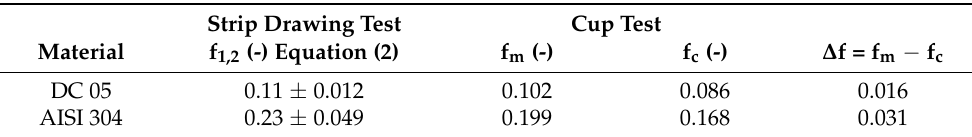
Table 6. Comparison of friction coefficients in the cup test from measured (experiment) and calculated (simulation) values of drawing